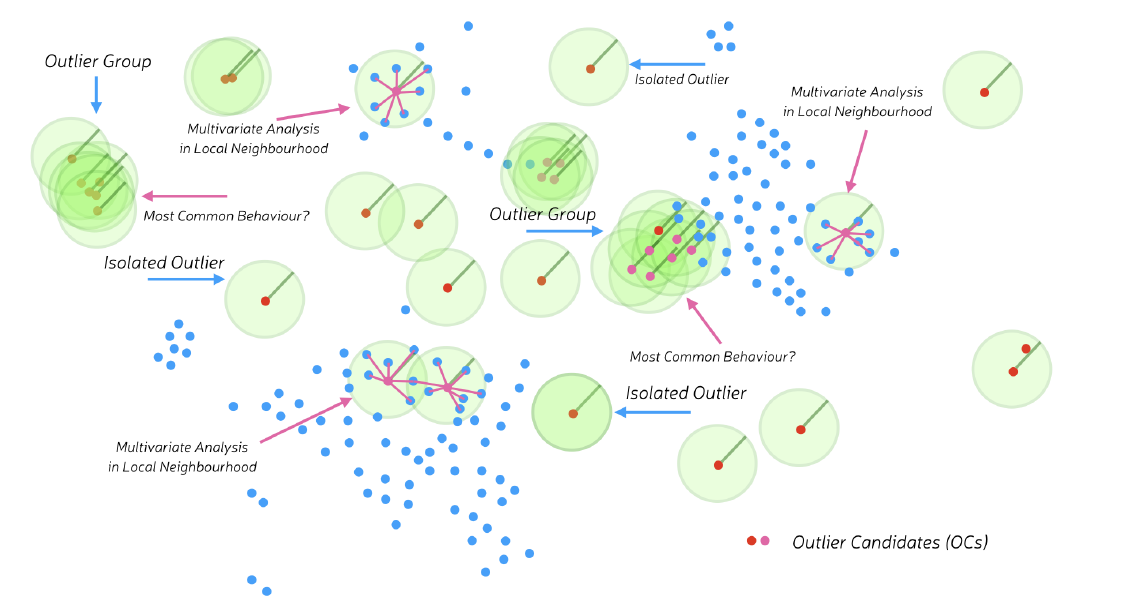
Figure 6. Schematic of identified outlier candidates, all nearest neighbors search, formation of Outlier Candidate (OC) groups and multivariate analysis in local